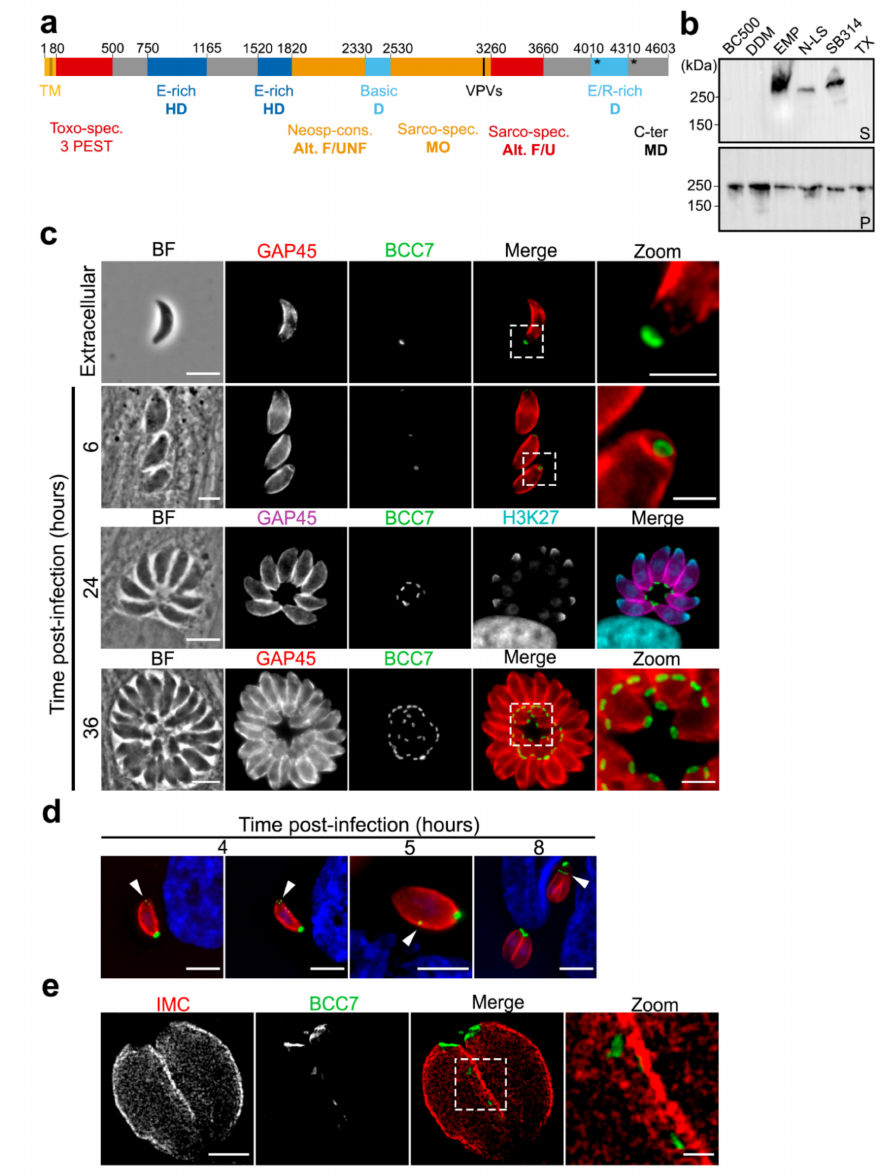
Figure 1. Main features of the T. gondii BCC7 protein. ( a ) Schematic representation of the BCC7